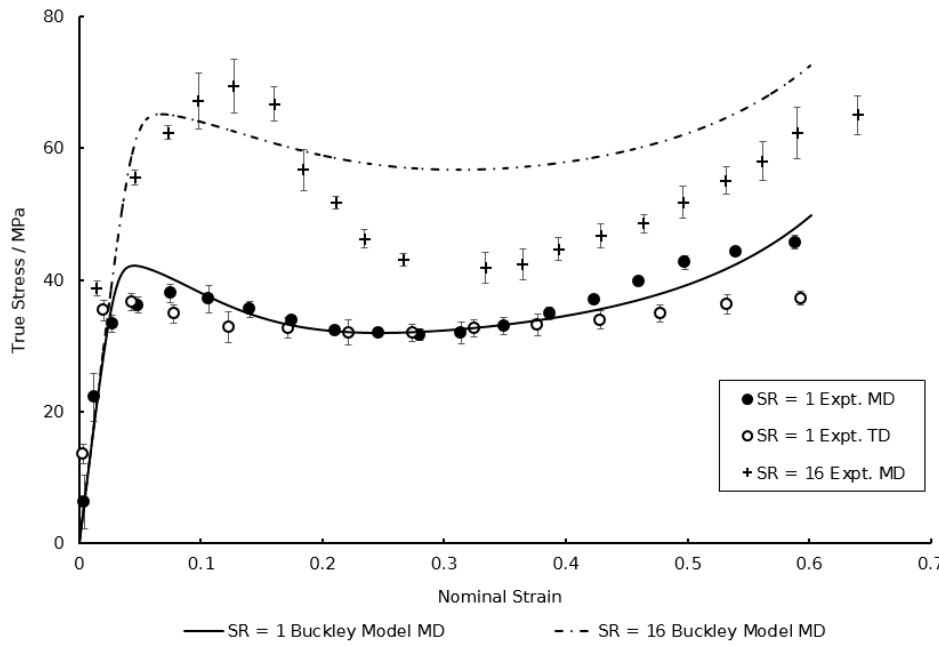
Figure 3. Comparison between simulated and experimental Equal Biaxial (EB) deformation behaviour of PEEK in machine and transverse directions at strain rates of 1 and 16 s -1 at a temperature of 130 °C.